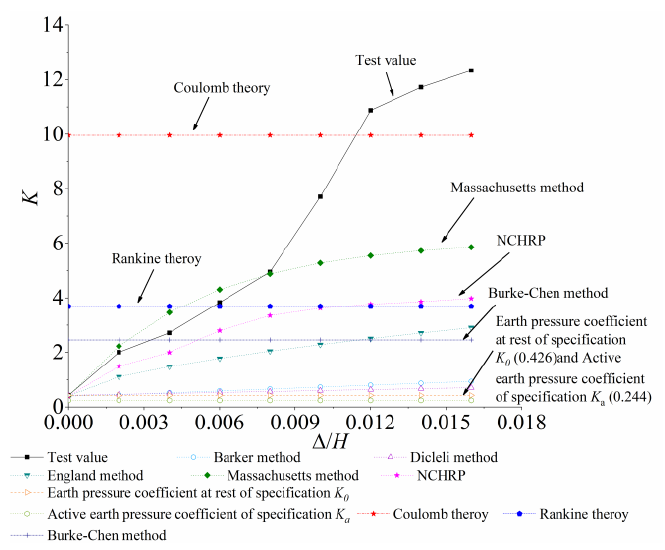
Figure 10. Relationship between ∆ / H and K p .